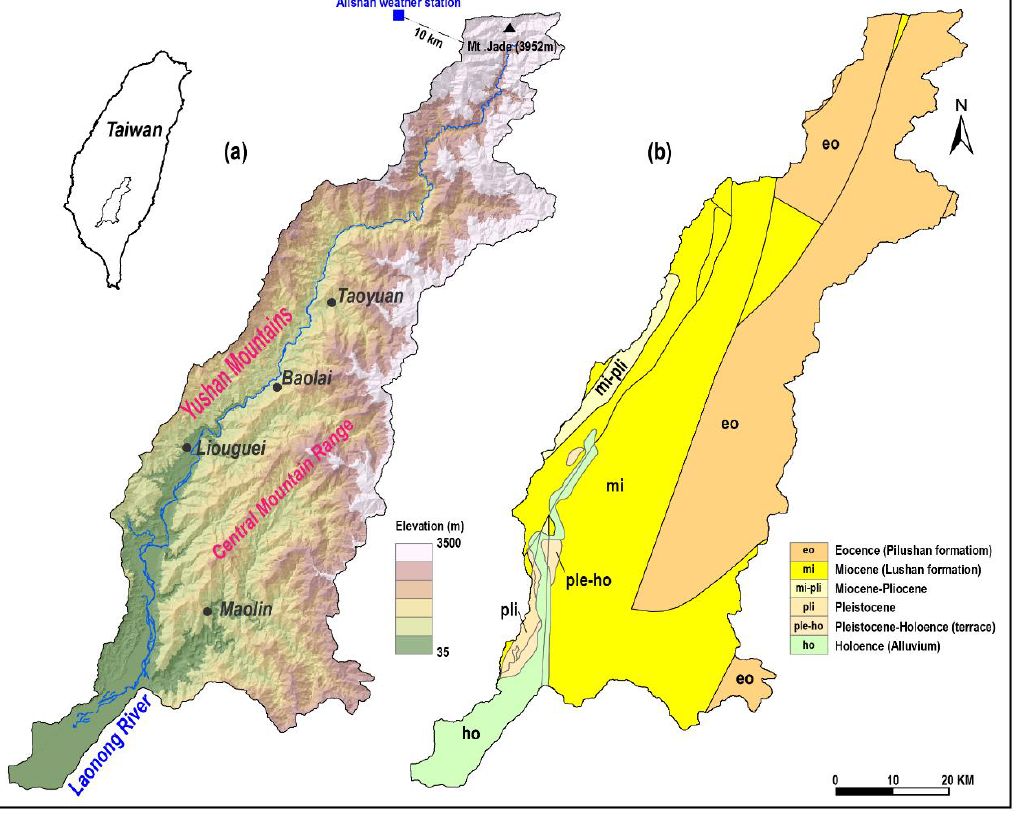
Figure 1. Location of the Laonong River watershed in Taiwan. ( a ) Color-shaded map of 20 m digital elevation model. ( b ) The geological map of the study area.